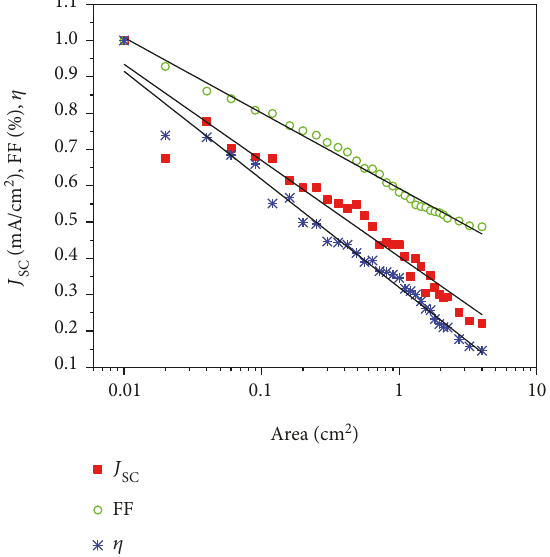
Figure 6: Normalized logarithmic scale for e ffi ciency ( η ), FF , and J SC . See text for more